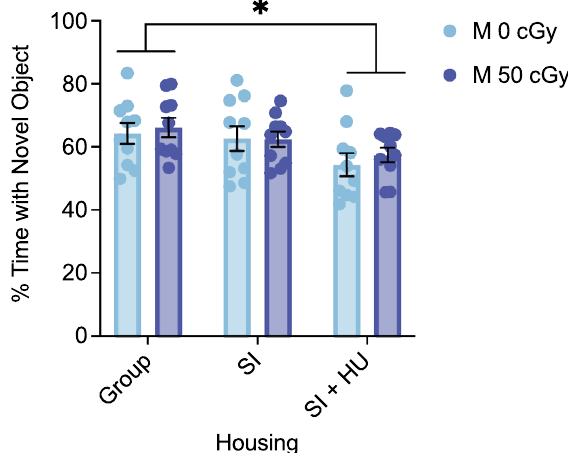
Figure 3. Combined stressors impair recognition memory. The novel object recognition (NOR) task was used to assess object recognition memory. ( a ) There was a significant main effect of Housing on % Time spent with the Novel Object during NOR Day 4 (F(2,54) = 4.523, p = 0.015, η 2 = 0.143). Animals in the Social Isolation + Hindlimb unloaded condition spent a significantly lower % Time with the Novel Object compared to Group housed animals (mean diff 9.280, 95%CI (1.433 to 17.127), p = 0.015). Males: n = 10 for all groups. * p <